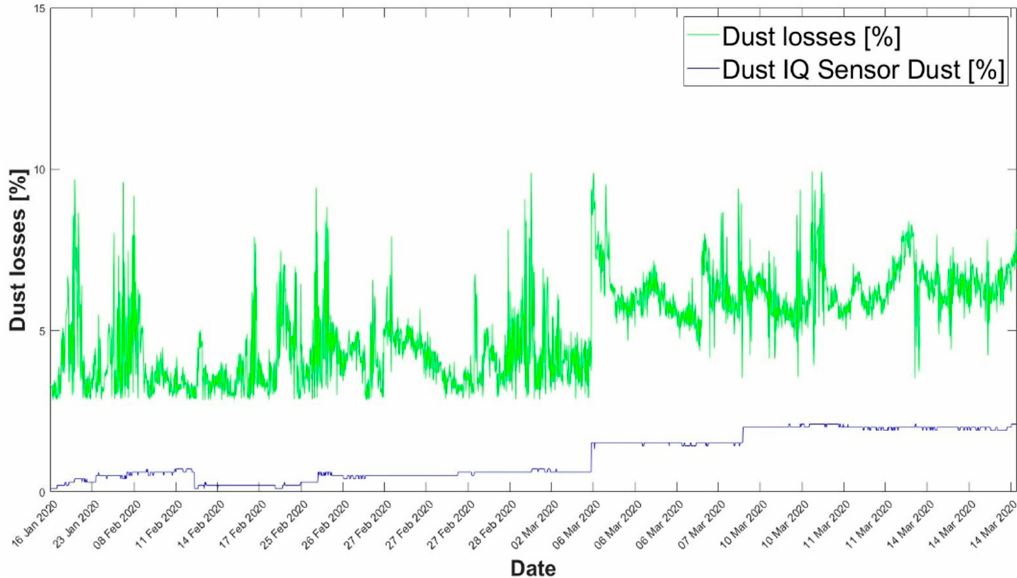
Figure 11. Variation in the production loss associated with dust and the dust accumulated in the environment around the experimental plant during the measurement campaign.